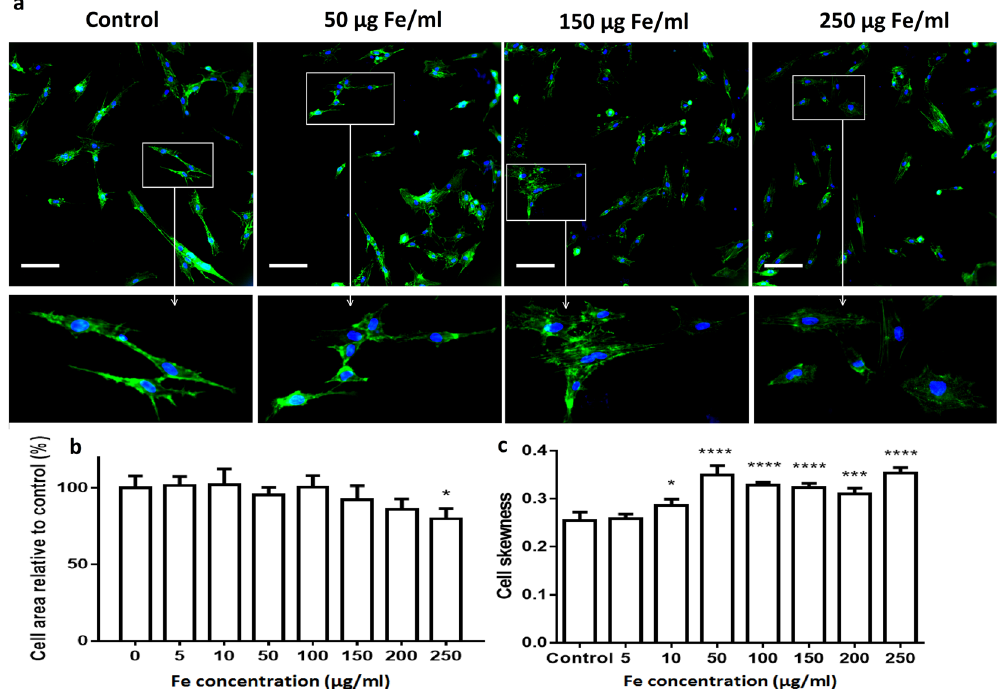
Figure 4. ( a ) Representative images of high-content imaging setup of hMSCs stained for nucleus with Hoechst (blue) and for actin with Acti-stain 48 (green), scale bar 100 µ m. From the images captured by high content analysis, the spreading of the cell was calculated ( b ), as well as the cell skewness (width of the cell over the length of the cell) as seen in ( c ). Data are represented relative to untreated control cells as mean ± SD for minimum 500 cells per condition, 3 replicates per condition. The degree of significance is indicated when appropriate * P < 0.05, ** P < 0.01, *** P < 0.001 and **** P < 0.0001 (one-way ANOVA, Dunnett post-hoc